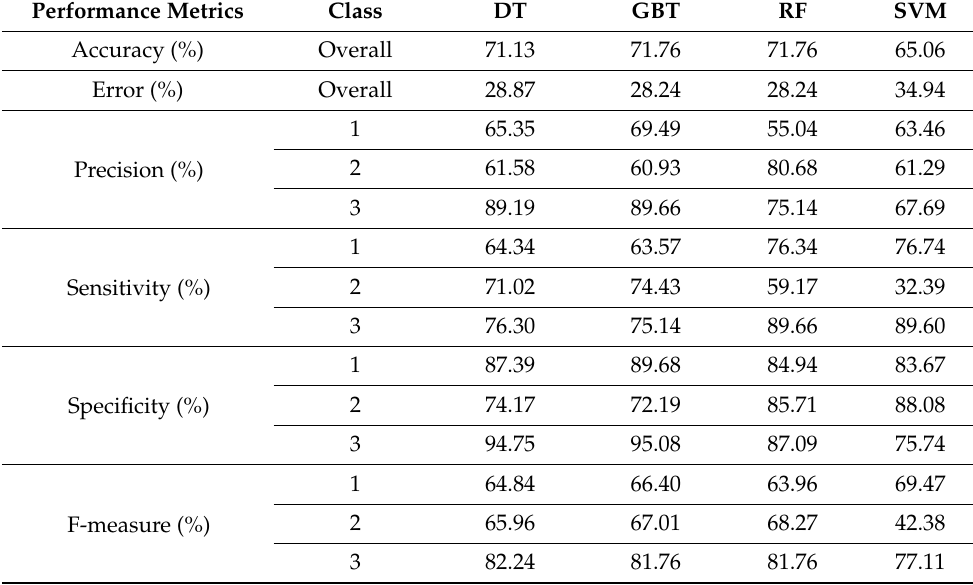
Table 5. Performance metrics of all selected algorithms.